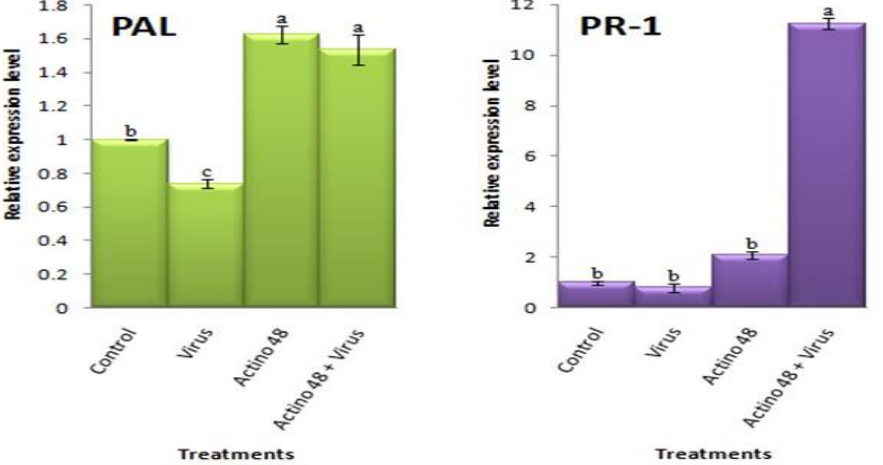
Figure 5. The relative expression level of the phenylalanine ammonia-lyase (PAL) and pathogen-related protein 1 (PR-1) genes in TMV-infected tomato plants at 21 days post-inoculation. Columns with the same letter do not differ significantly.